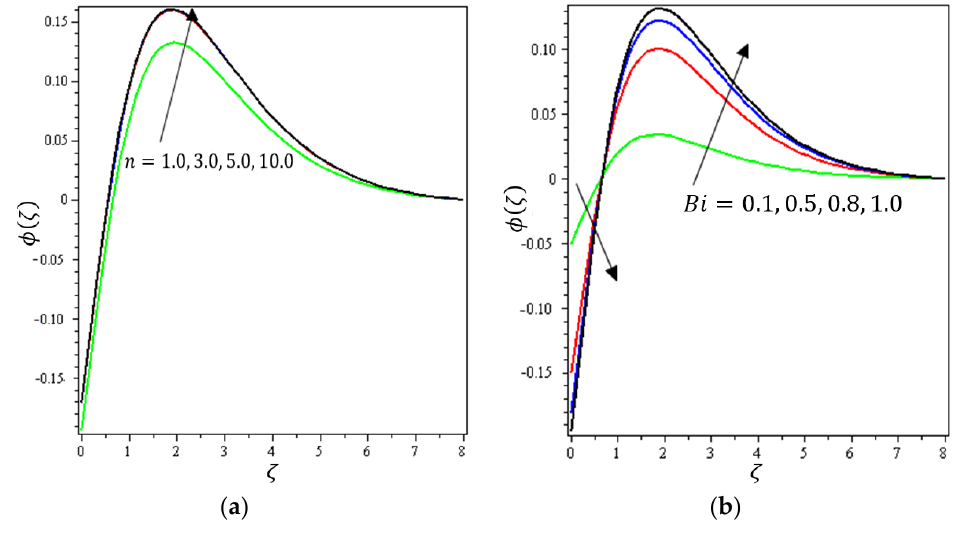
Figure 14. Influence of ( a ) chemical order 𝑛 and ( b ) Biot number 𝐵𝑖 on 𝜙(𝜁) .